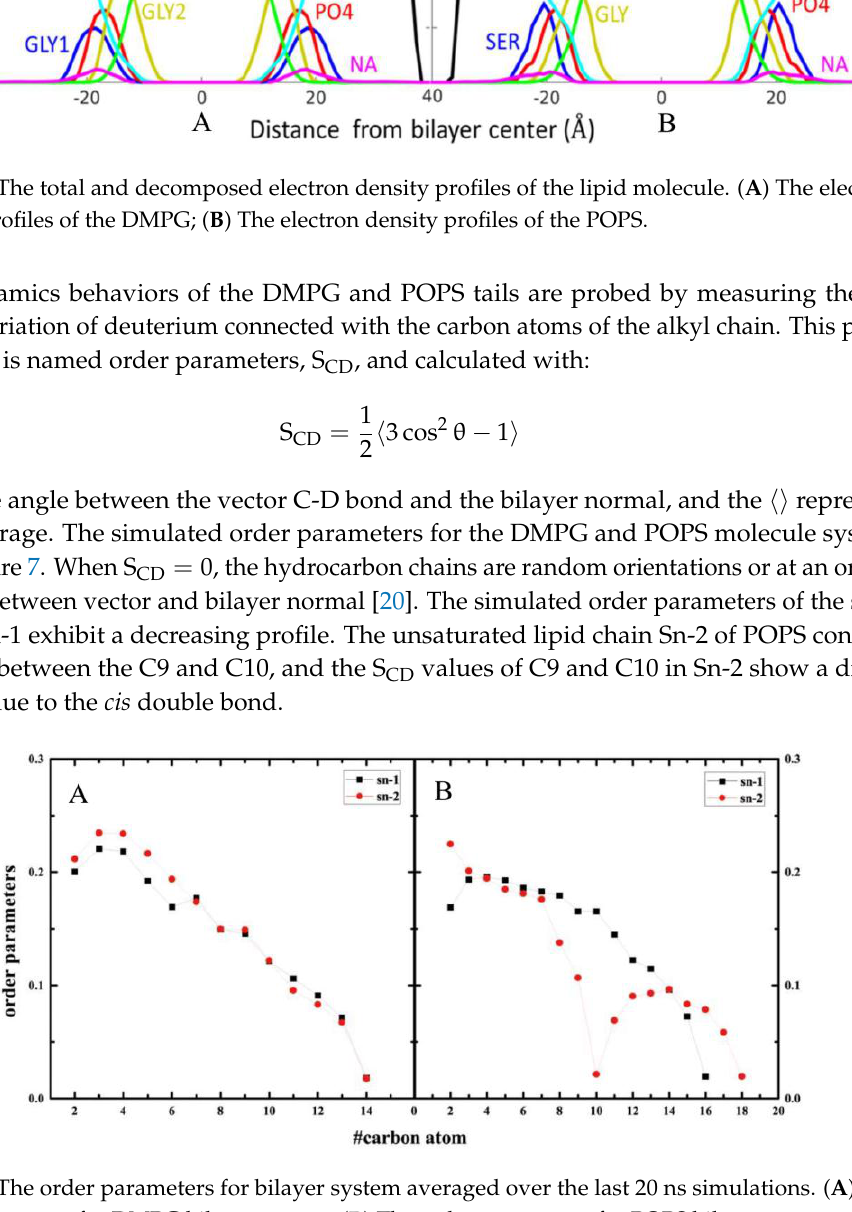
Figure 7. The order parameters for bilayer system averaged over the last 20 ns simulations. ( A ) The order parameters for DMPG bilayer system; ( B ) The order parameters for POPS bilayer system. Figure 8. Probability distribution function of the angle between the lipid head P-N vector and the bilayer normal of the DOPC and POPE bilayer system from the last 20 ns.